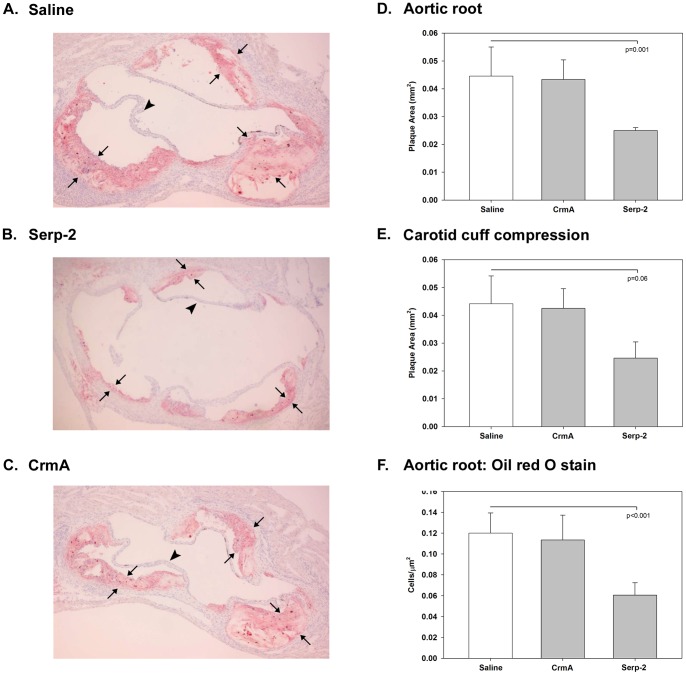
Serp-2 reduces plaque growth in Apolipoprotein E deficient (ApoE−/−) mice.Hyperlipidemic ApoE−/− mice were infused with a bolus of Serp-2, CrmA or control saline after carotid cuff compression injury. Histological sections taken at the aortic root, where no surgical injury occurs, and distally at the site of cuff injury were examined. Cross sections taken at the aortic valve level (Oil red O staining) demonstrate plaque growth in saline treated control mice (A) (N = 11). A significant reduction in plaque area is detectable with Serp-2 (B, N = 11), but not with CrmA (C, N = 11) treatment compared to saline treated controls. Morphometric analysis of plaque area at the aortic root in ApoE−/− mice, where no surgery has been performed, demonstrated that Serp-2 inhibited aortic plaque and macrophage/foam cell invasion (D, p<0.001) to a greater extent than at sites of vascular carotid compression surgery in the same model (E, P = 0.06). Oil red O staining confirmed a reduction in fatty plaque in the ApoE−/− aortic root (F), indicating decreased foam cell/macrophage invasion (p<0.001). Thin arrows bracket intimal plaque limits, larger arrows identify an aortic leaflets, large arrow with open base points to area of fatty, foam cell (macrophage) invasion; Magnification – 100X.